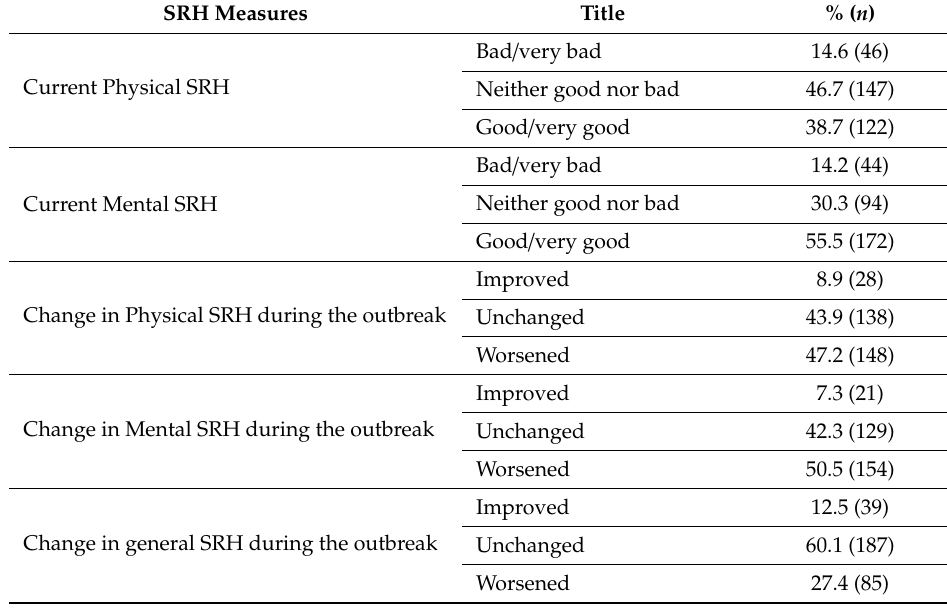
Table 2. Self-rated health (SRH)